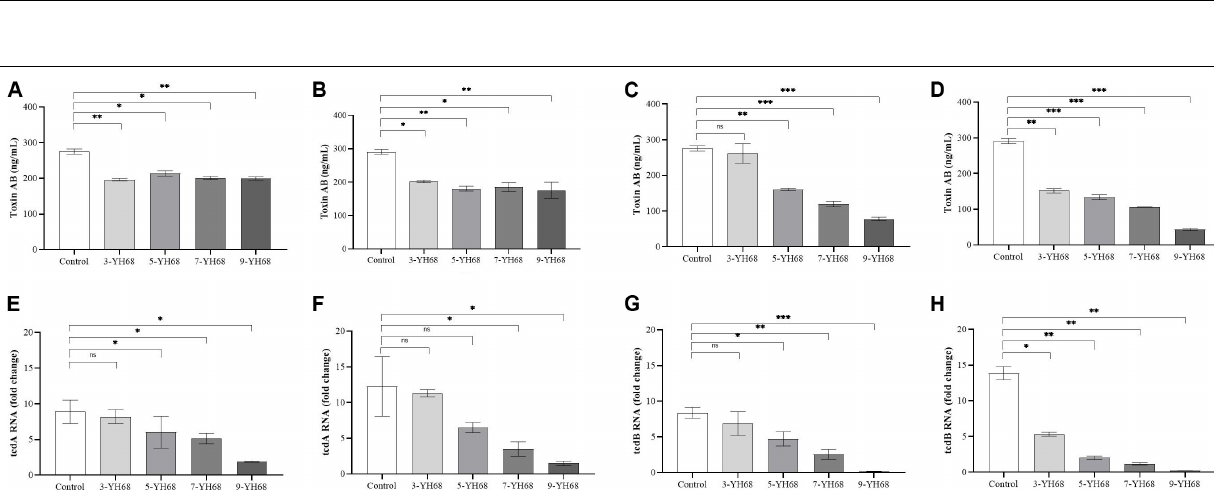
Frontiers in Microbiology |